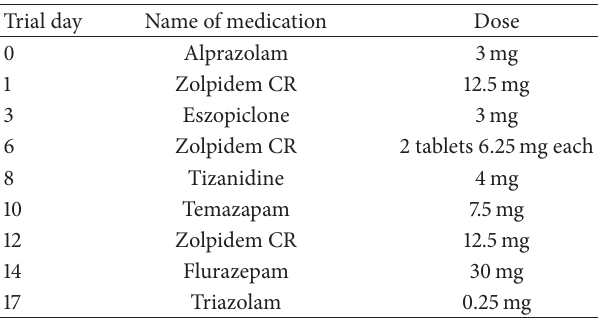
Table 1: Medications by trial day and